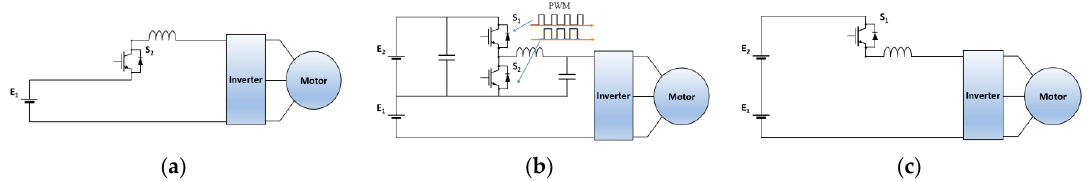
Figure 3. Operation of the two-battery HEECS chopper: ( a ) Low-speed range; ( b ) middle-speed range; ( c ) high-speed range.